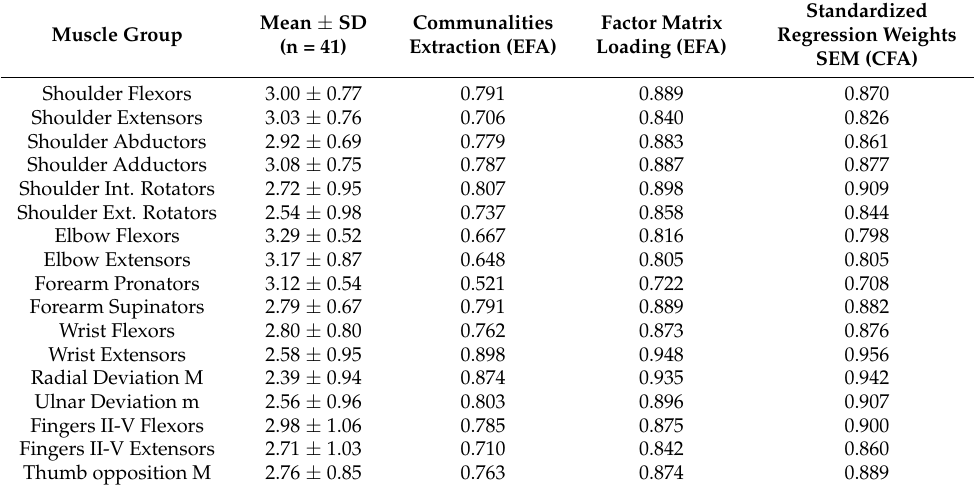
Table 5. Factor loadings for UE MMT assessment with EFA and CFA.